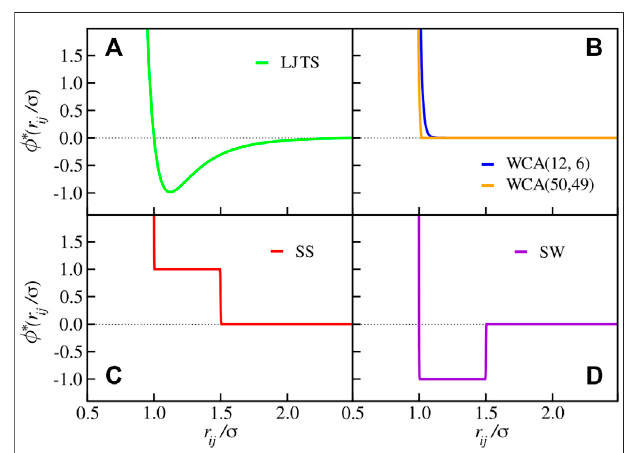
FIGURE 1 | Potentials of interacting particles used for the simulations. (A) Potential of Truncated and Shifted Lennard-Jones. (B) WCA ( 12 , 6 ) potential and the hard sphere pseudo-potential WCA ( 50 , 49 ) . (C) and (D) Square-Shoulder potential continuous and continuous Square-Well respectively, given by Eq. 4